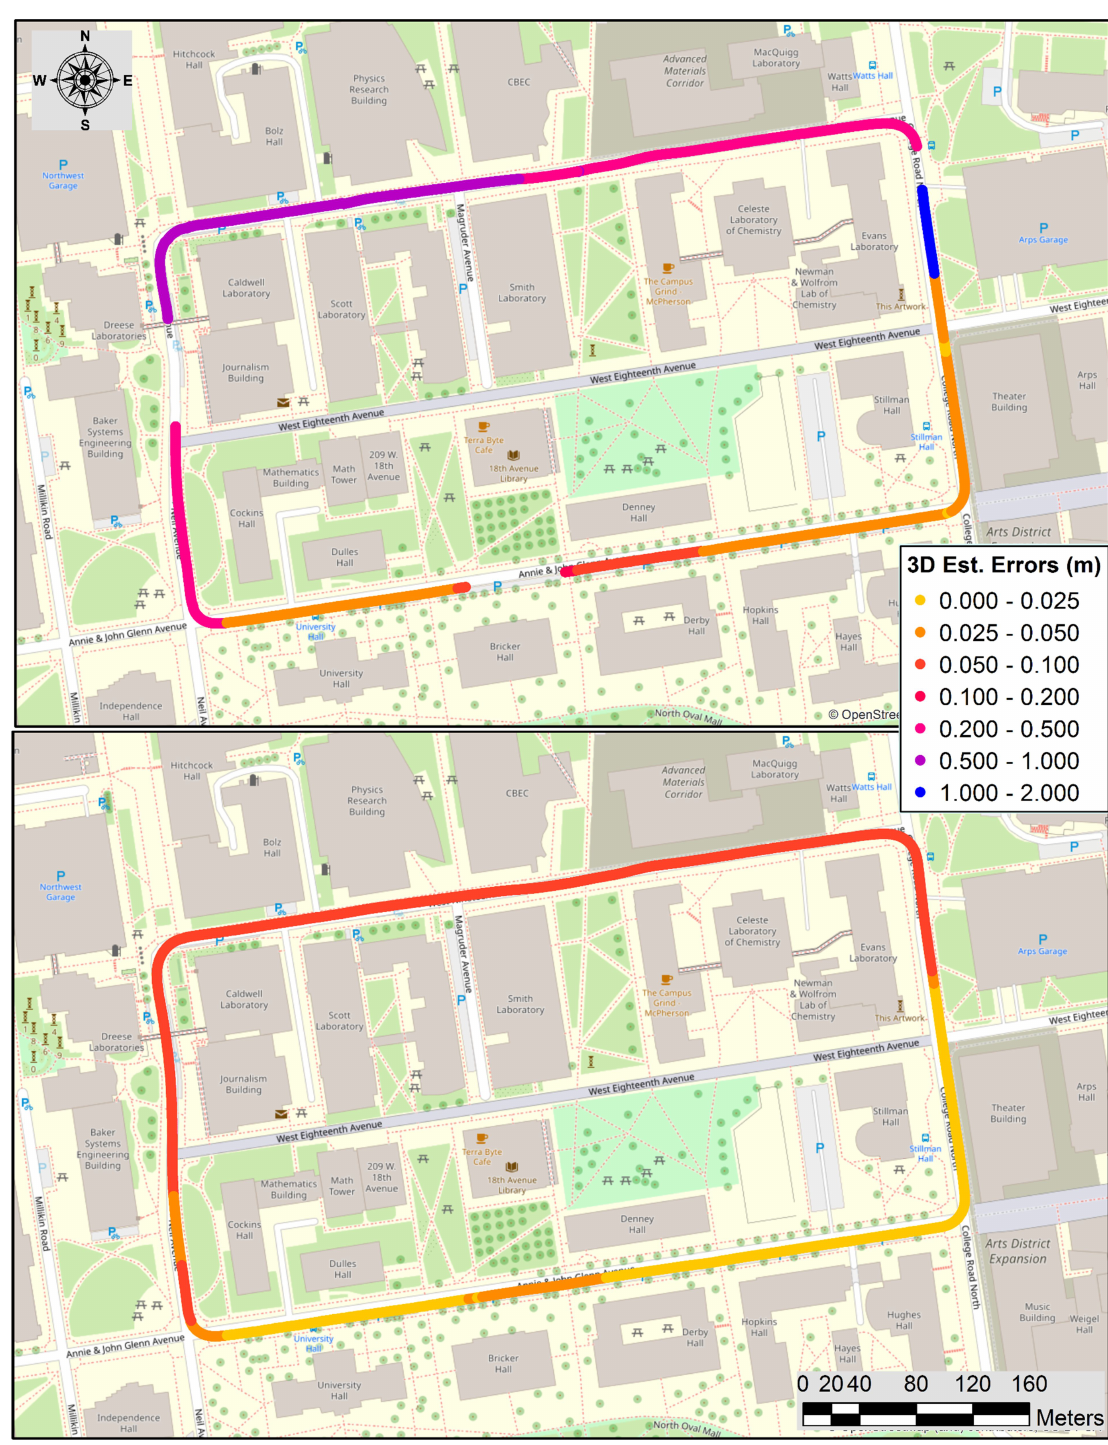
Figure 4. Georeferencing solutions through the trajectory for the 3rd loop; left: GNSS only; right: GNSS/IMU integration (colors in the legend indicate 3D estimated errors in